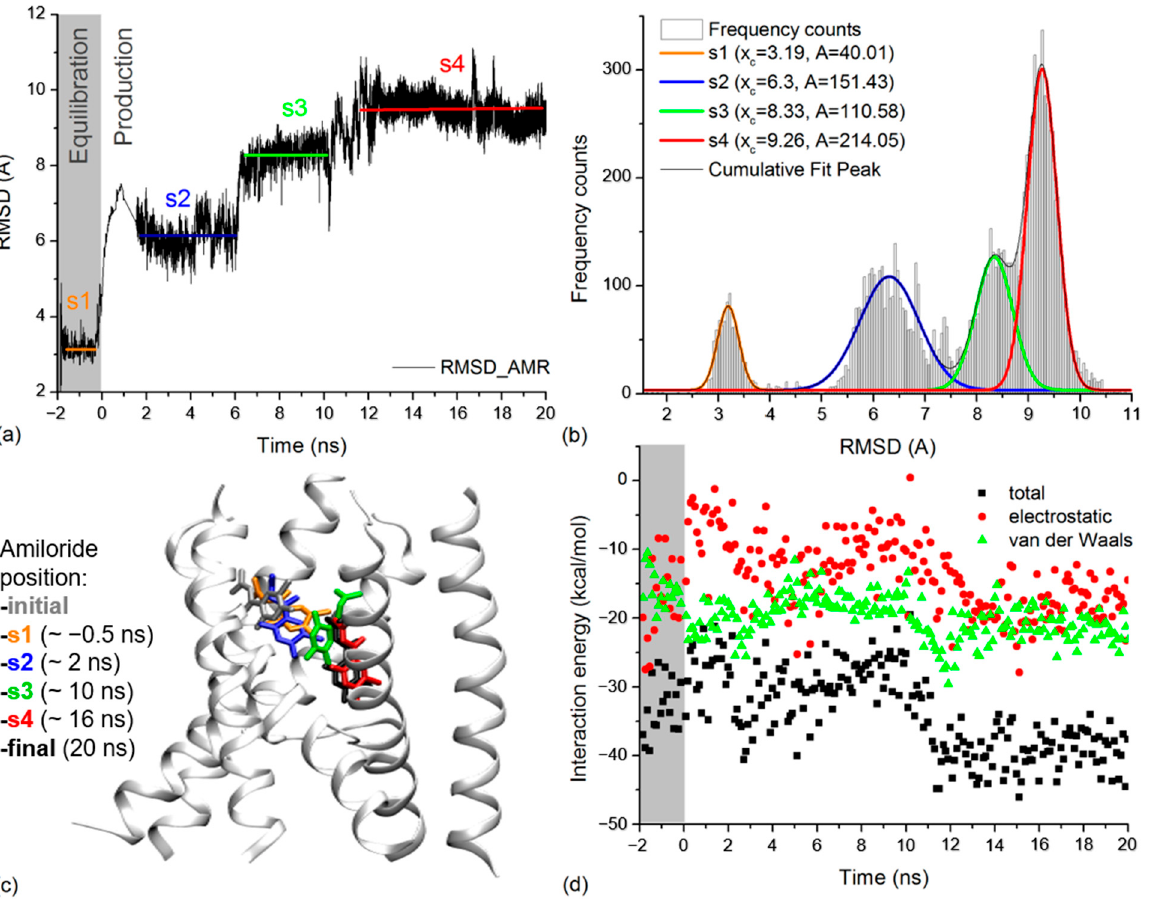
Figure 4. ( a ) RMSD time series for amiloride molecule calculated based on the equilibration and production molecular dynamics simulation. The equilibration time is in negative values while the production dynamics to start at 0 ns. The states of amiloride are marked on the figure in agreement with results in ( b ): state 1 (s1) in orange, state 2 (s2) in blue, state 3 (s3) in green and state 4 (s4) in red. The labeling and colors of states will also be applied in ( b , c ); ( b ) The frequency counts for amiloride RMSD values in ( a ) are represented as light grey columns. The Gauss lines that fit them and the cumulative peak fit are represented on the figure. In the case of each Gauss line associated with a state of amiloride we labeled the central value (x c ) and the area under the curve (A); ( c ) Detail on xENaC TM region with amiloride found in the positions associated with the identified states. For each state, we wrote in brackets the exact time at which the snapshot was taken. The initial location of amiloride is presented in grey and the final position is presented in white; ( d ) Interaction energies between amiloride and xENaC during the equilibration (grey background) and production dynamics (white background). The total interaction energies are presented in black squares, the Van der Waals interactions are in green, and the electrostatic interactions are in red.